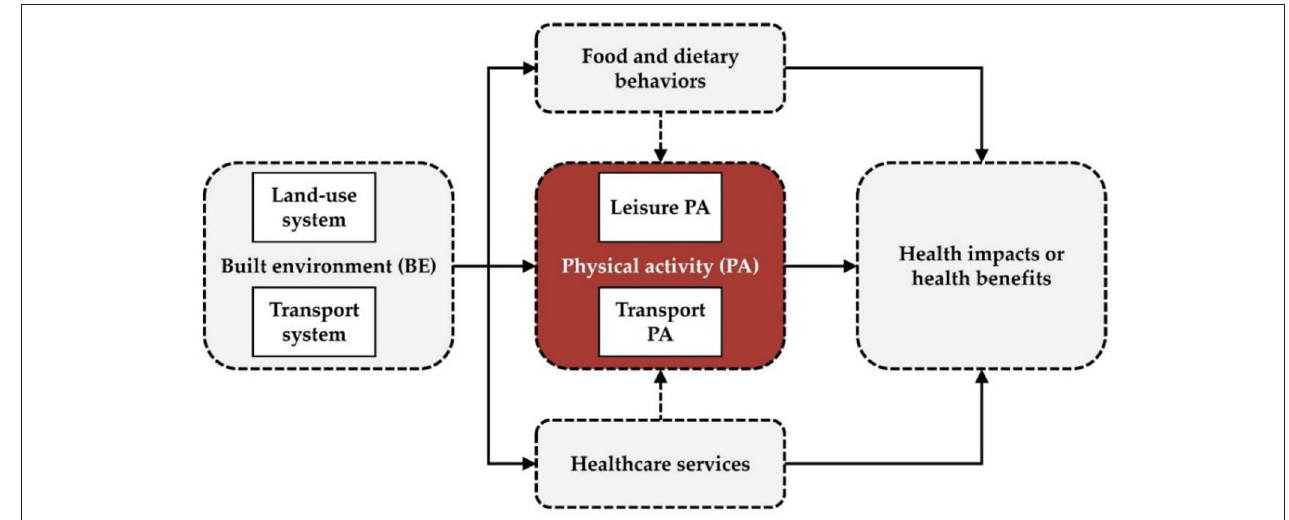
FIGURE 4 | Overview of the built environment and health connection via physical